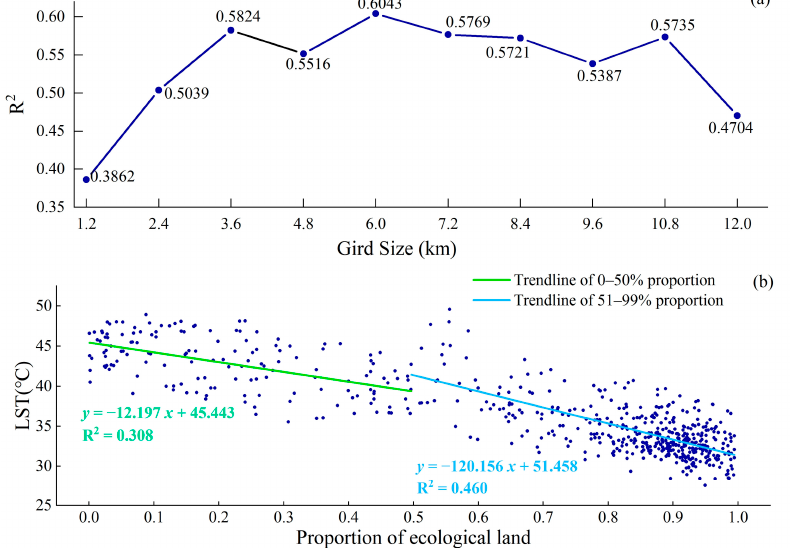
Figure 9. The influence of different grid lengths on the fitting effect: ( a ) Fitting relationship between ecological land proportion and LST in different grid sizes. ( b ) The threshold value of ecological land proportion (grid size is 3.6 km).